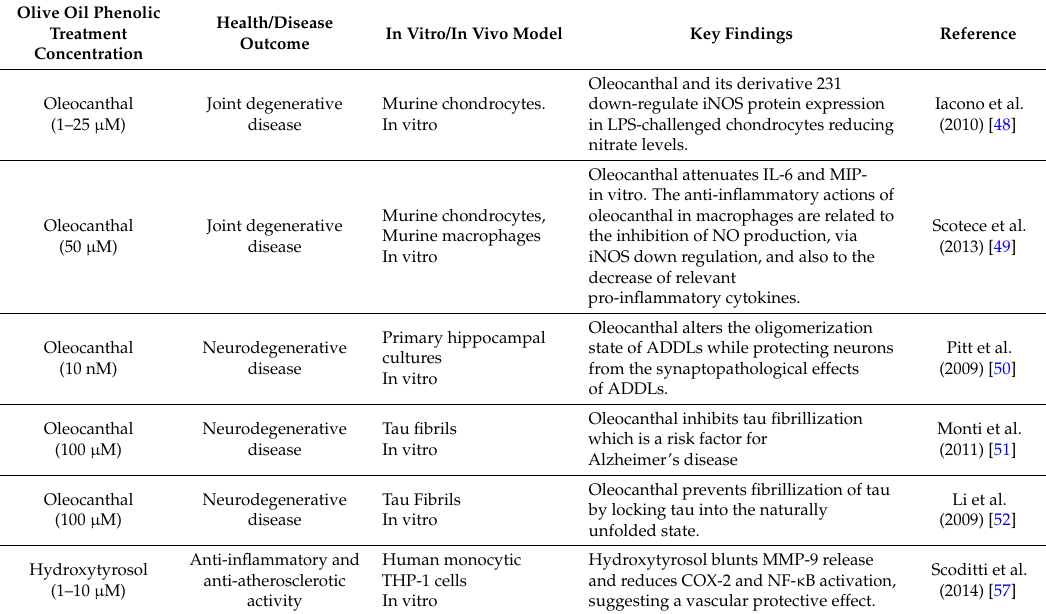
Table 1. In vitro and in vivo studies demonstrating the effect of oleocanthal, oleuropein, and hydroxytyrosol on markers of